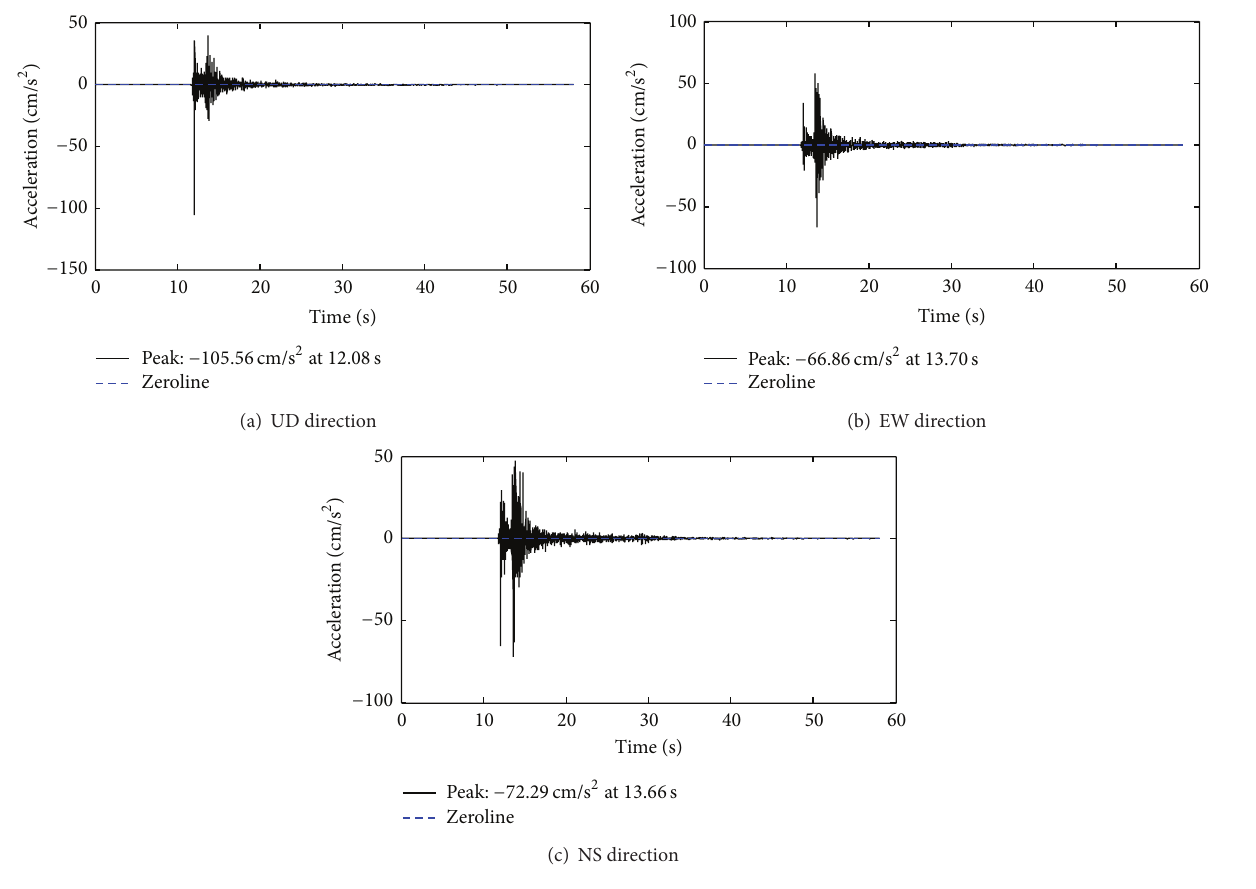
Figure 10: Acceleration time